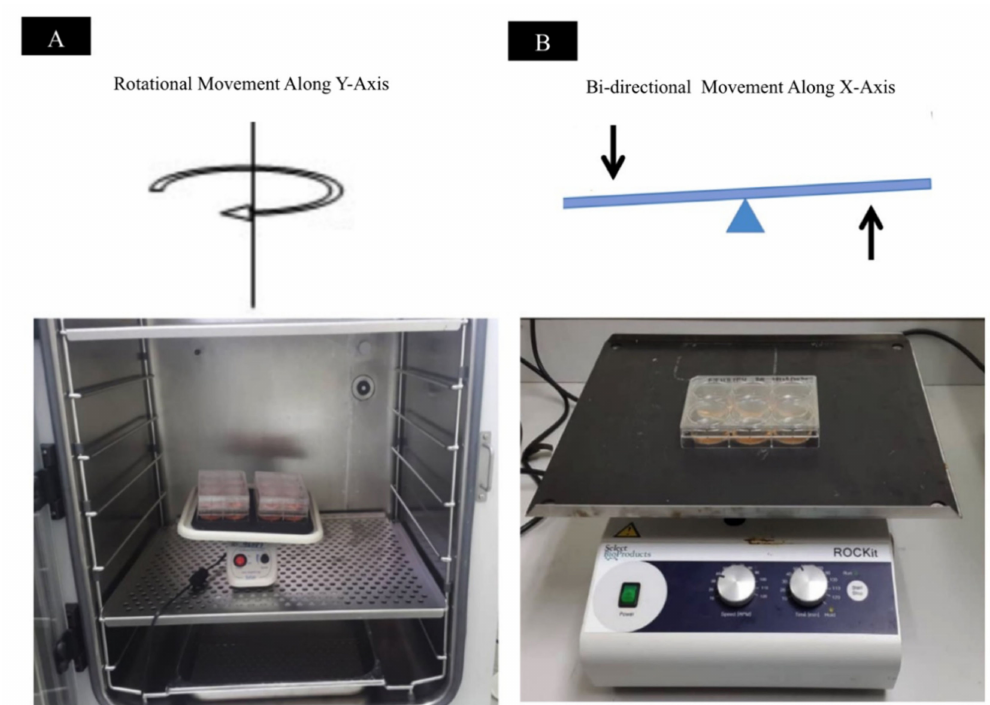
Figure 10. Mechanical stimulation introduced onto ASC-based self-assembled scaffolds in culture. ( A ) Shows rotational movement along the Y -axis and ( B ) shows bidirectional movement along the X